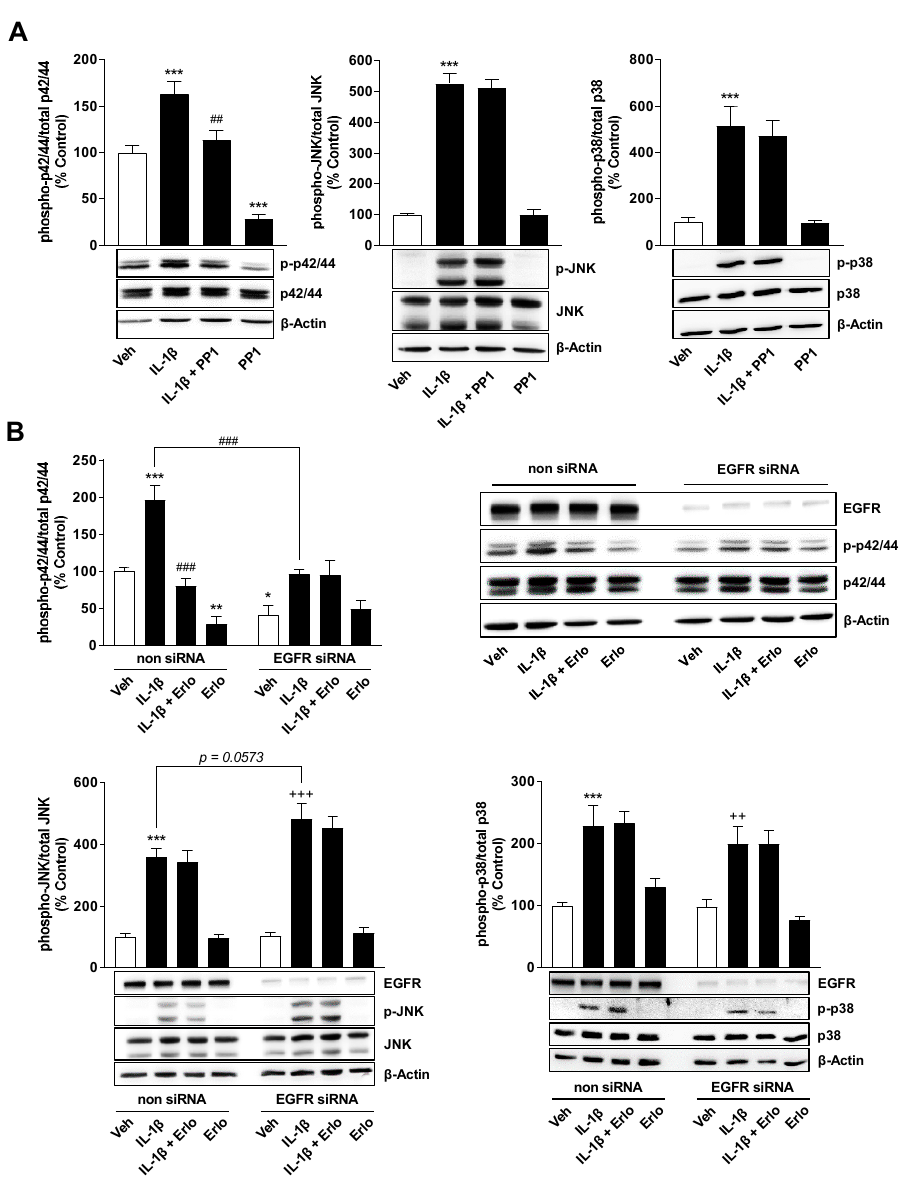
Figure 6. The Src kinase inhibitor PP1 and the EGFR TKI erlotinib inhibit IL-1 β -induced p42/44 MAPK, but not JNK and p38 MAPK activation. ( A ) Effect of PP1 at 10 µ M on IL-1 β -induced or basal p42/44 MAPK, JNK and p38 MAPK activation in A549 cells. ( B ) Effect of erlotinib (Erlo) at 3 µ M on IL-1 β -induced or basal p42/44 MAPK, JNK and p38 MAPK activation in cells transfected with nonsilencing siRNA (non siRNA; negative control siRNA) or EGFR siRNA at 10 nM each. In ( A ), the cells were preincubated with PP1 for 1 h followed by the addition of IL-1 β (10 ng/mL) or vehicle and coincubation for 30 min. In ( B ), erlotinib was added immediately before IL-1 β or vehicle followed by coincubation for 30 min. All percentage values shown refer to the respective vehicle control, which was set to 100%. The values shown in the histograms are based on densitometric analyses of blots, whereby the phosphorylated forms were normalized to the respective total form. In the labelling of the MAPK blots ( A , B ) the prefix “p-” stands for “phospho-”. The blots shown are representative. The data are mean values ± SEM of n = 10 ( A , left), n = 4 ( A , middle, B ) or n = 5 ( A , right) experiments per group. * p ≤ 0.05, ** p ≤ 0.01, *** p ≤ 0.001 vs. vehicle control ( A ) or vehicle control of non siRNA transfection ( B ); ## p ≤ 0.01, ### p ≤ 0.001 vs. IL-1 β ( A ) or IL-1 β in non siRNA-transfected cells ( B ); ++ p ≤ 0.01, +++ p ≤ 0.001 vs. vehicle control of EGFR siRNA transfection; one-way ANOVA with Bonferroni’s post hoc